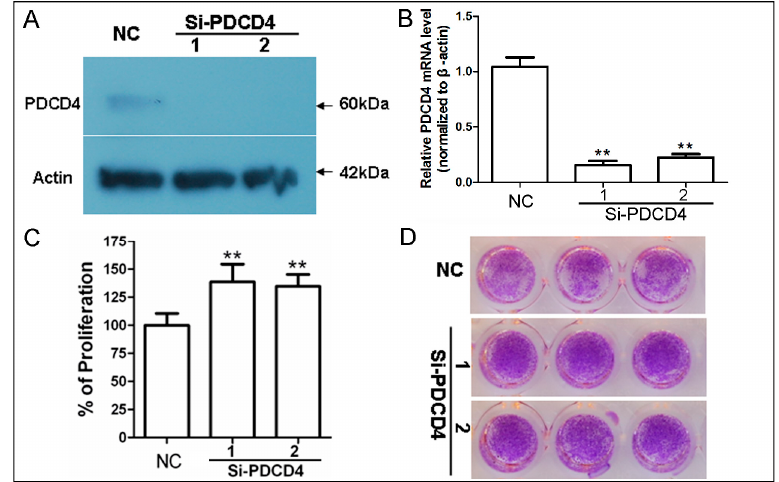
Figure 2. Knockdown of PDCD4 promotes keratinocytes proliferation. ( A ) Verification of PDCD4 knockdown in low-density HaCaT cells transfected with 50 nM siRNAs by western blot; and ( B ) real time PCR; ( C ) Proliferation assay in HaCaT cells transfected with PDCD4 siRNAs for 48 h with the CCK-8. Results represent the mean ± SD of three independent experiments. **, p < 0.001; ( D ) Crystal violet stain for clonogenicity capacity analysis of HaCaT cells silencing PDCD4 for 5 days in 96-well plate. NC, negative control siRNA. SD, standard deviation.